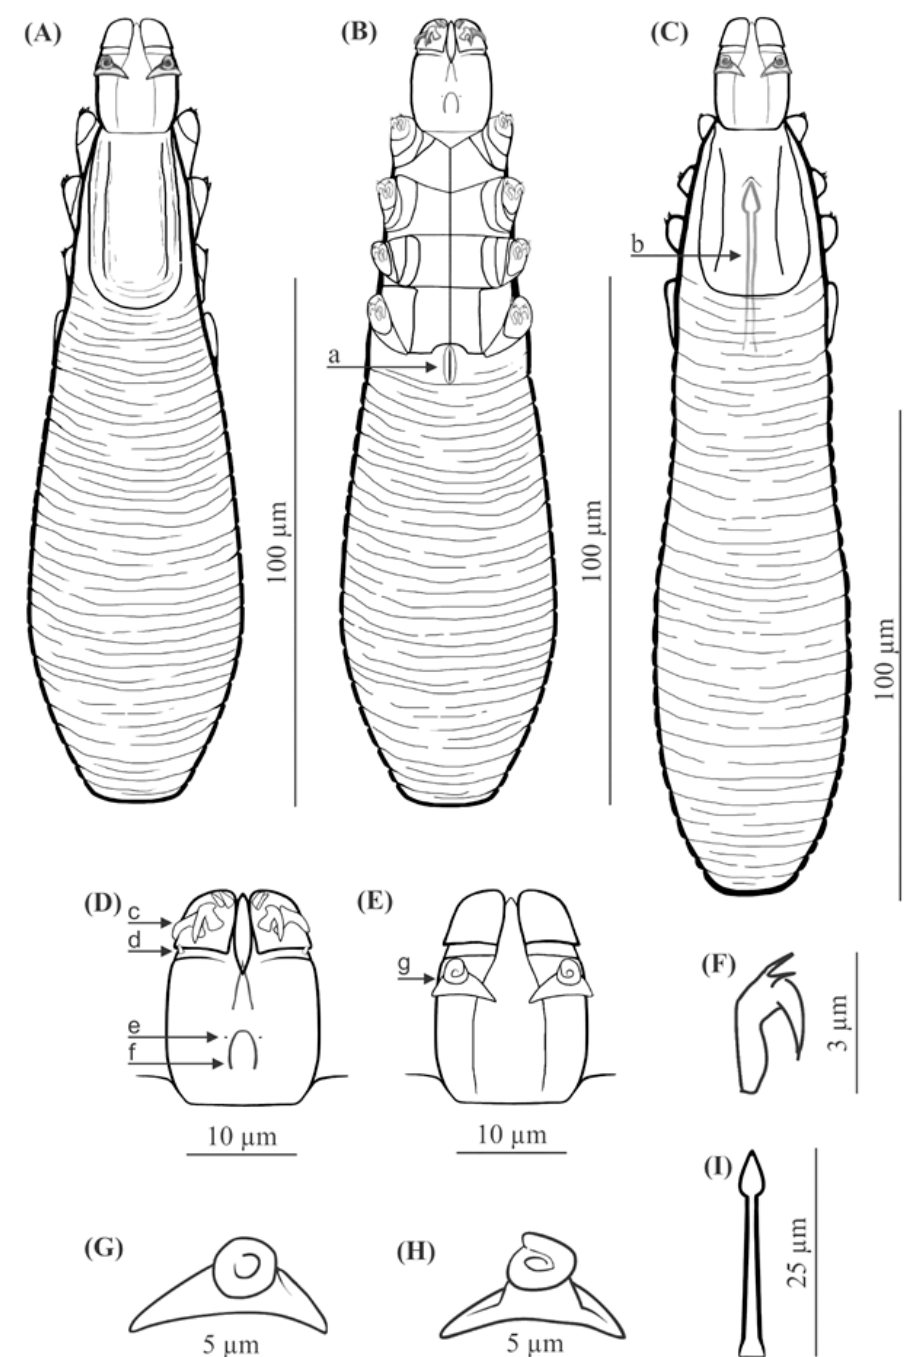
Figure 1. Demodex crocidurae sp. nov.: female, dorsal view ( A ), female, ventral view ( B ), male, dorsal view ( C ), gnathosoma, female, ventral view ( D ), gnathosoma, female, dorsal view ( E ), claw on the leg ( F ), supracoxal spine, dorsal view ( G ), supracoxal spine, lateral view ( H ), aedeagus ( I ); a: vulva, b: aedeagus, c: spines on palps, d: seta v”F , e: subgnathosomal seta (seta n ), f: pharyngeal bulb, g: supracoxal spine (seta elc.p ).